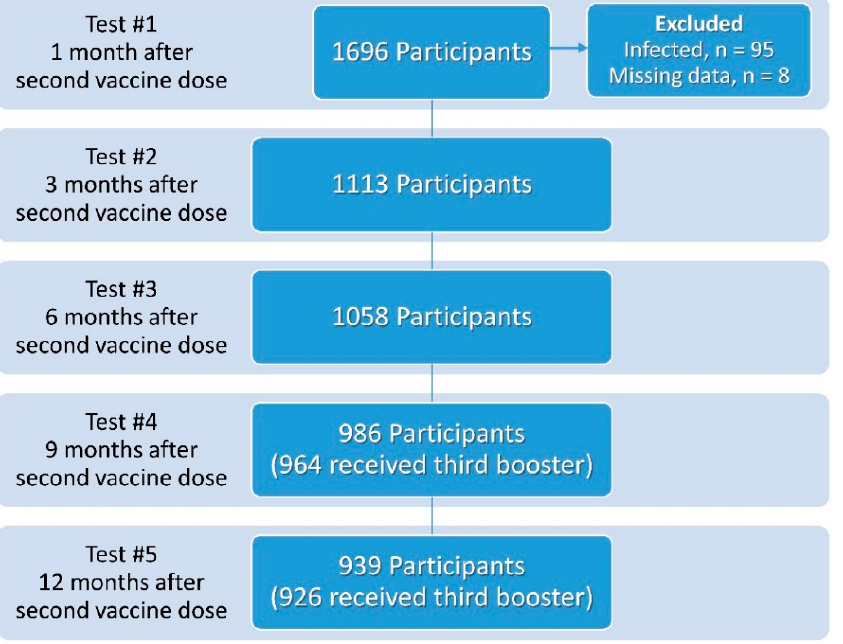
Figure 1. Number of participants at each time